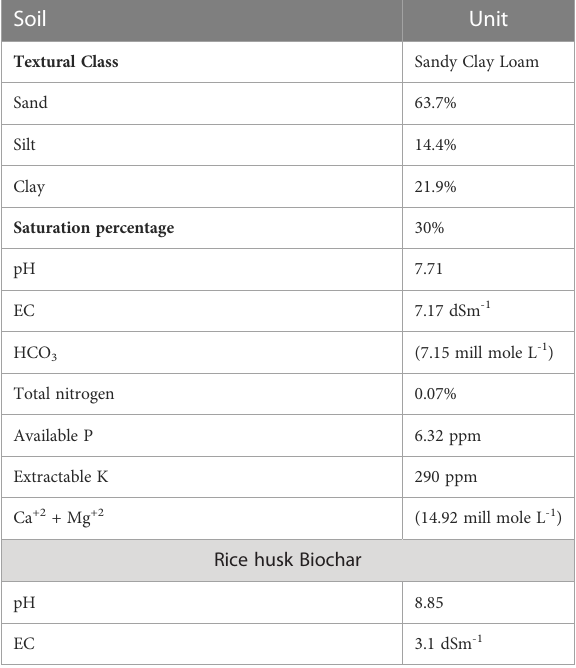
TABLE 1 Physicochemical properties of soil.